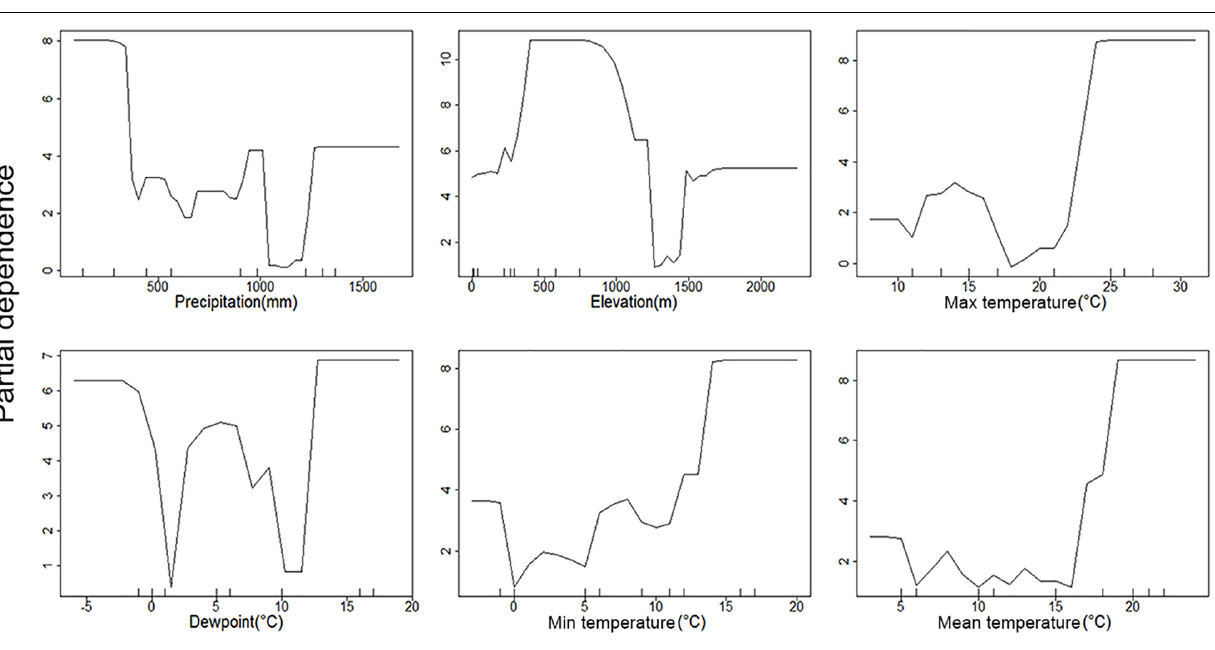
Random forest analyses indicate that the predictive strengths (mean decrease in accuracy) of the abiotic factors were generally high. The sensitivity, or the proportion of correctly predicted species, remained high for absence in both